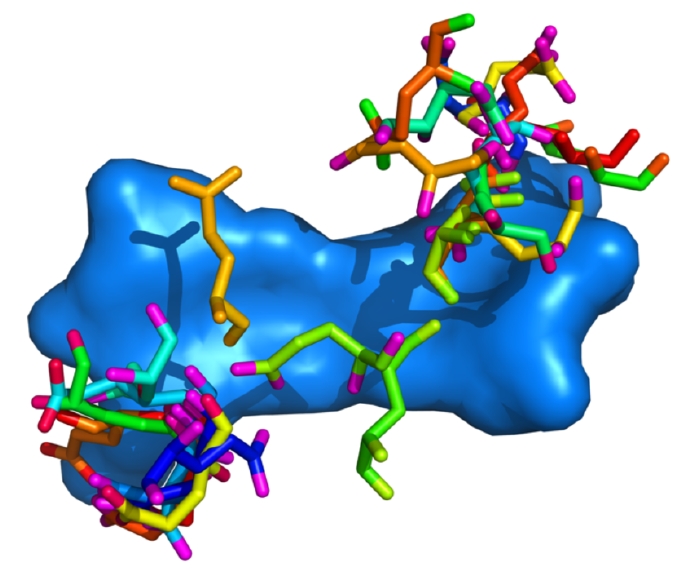
Figure 8. Positioning of glutamic acid residues with regards to the DNA dinucleotide. Residue–dinucleotide steps were superimposed using the Kabsch algorithm. All dinucleotide steps are represented by the step with minimal RMSD from all other